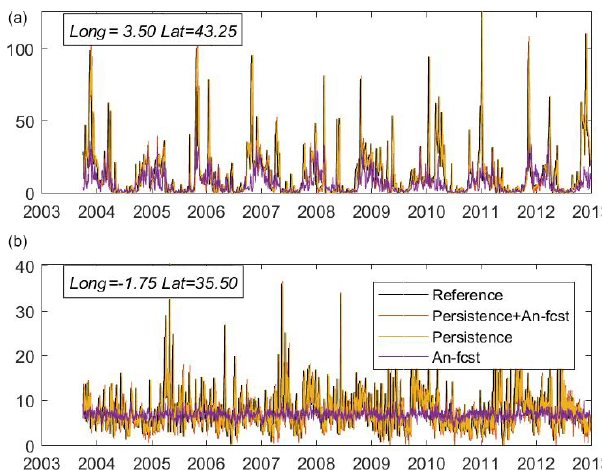
Figure 6. Time series of marine-litter concentration (in kgkm − 2 ) for (a) a location where the analogues-based forecast works well and (b) a location where it performs worse. The plots show the ref- erence values, the analogues-based forecast, the 7d long persistence and the 7d long persistence in combination with the forecast of the concentration